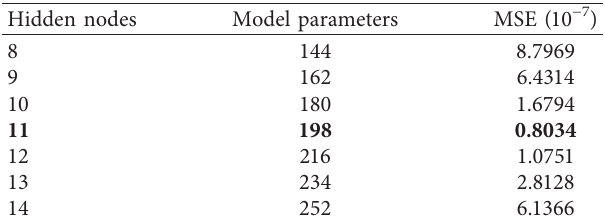
Table 1: Different number of hidden nodes on the complexity and the accuracy of